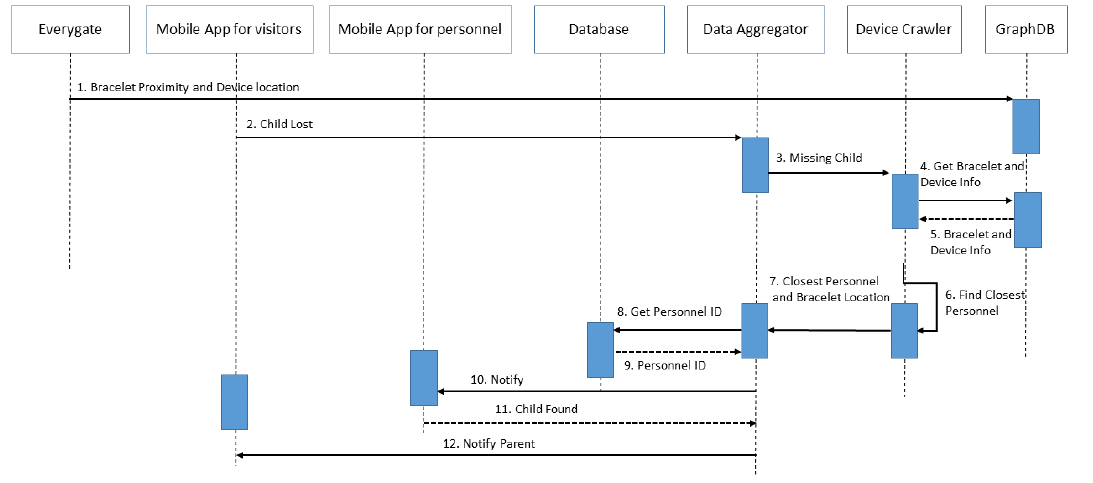
Figure 14. The Unified Modeling Language (UML) diagram of the MylosKidFinder use